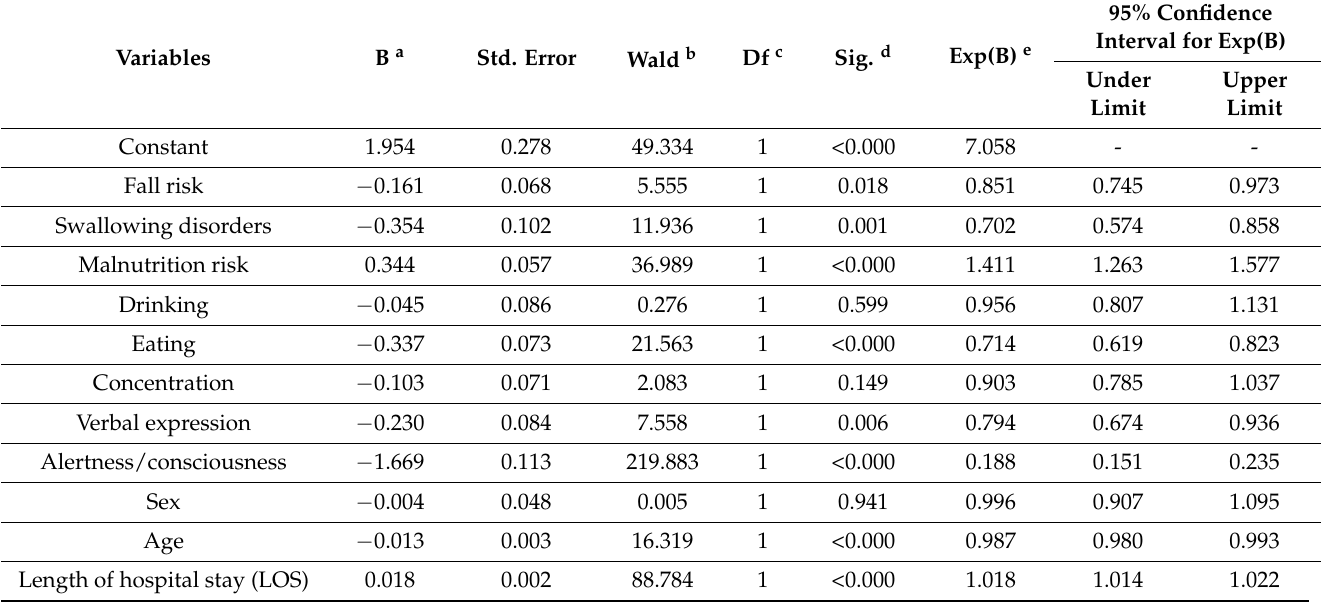
Table 6. Multivariate logistic regressions predicting PP among discharged geriatric inpatients, adjusted for age, sex and length of stay (LOS; n =